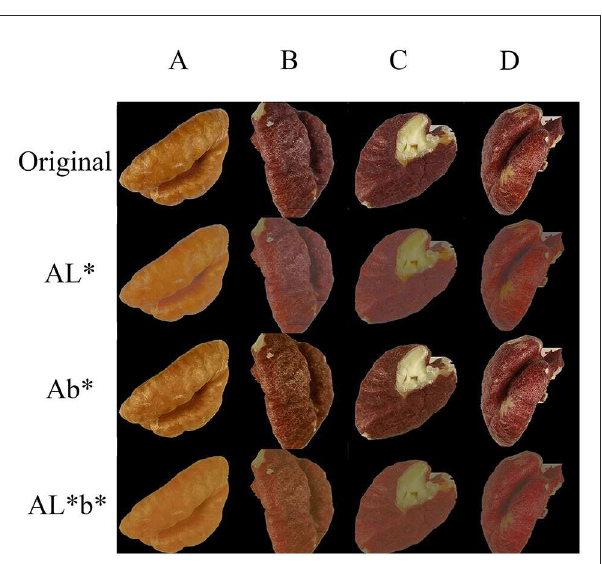
FIGURE2 Datasets. The four columns are the four sets of experimental images of hickory nuts kernels, A, B, C, and D; the “Original” row is the acquired original images, AL* is aggregated images from the L* channel, Ab* is aggregated images from the b* channel, and AL*b* is aggregated images from both the L* and b*